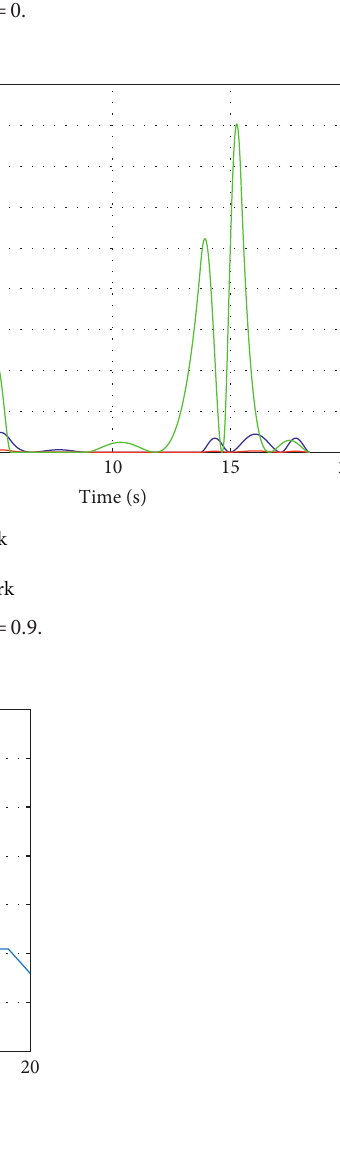
Figure 9: Dug weight error through each